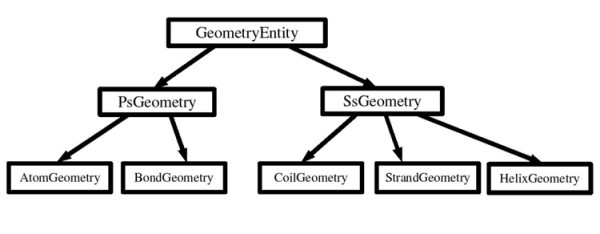
The class hierarchy of the geometry engine.